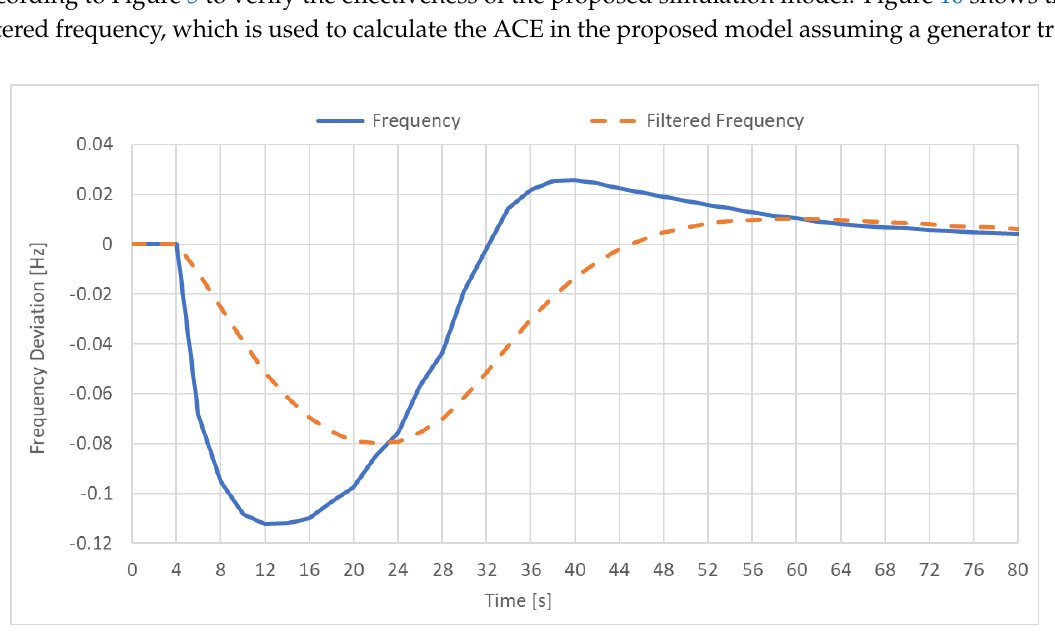
Figure 10. Comparison of frequency and filtered frequency using low-pass filter.